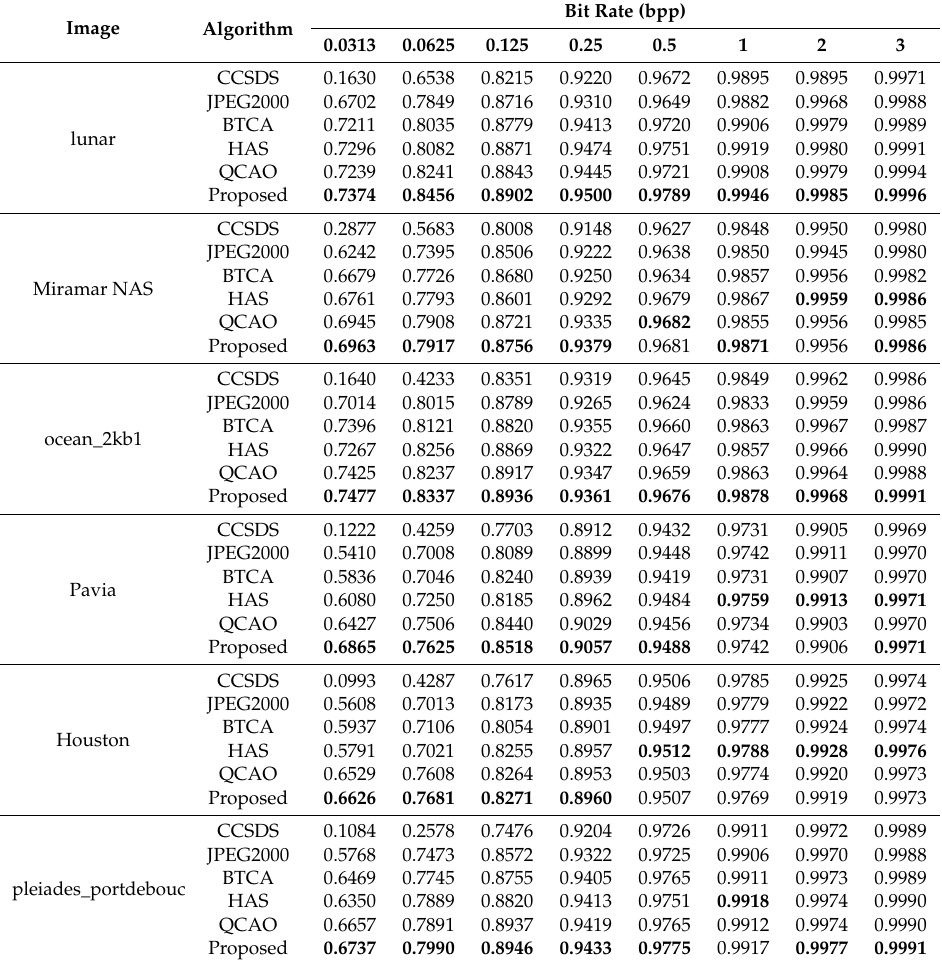
Table 4. MS-SSIMs (dB) of the proposed compression method and other scan-based compression methods.